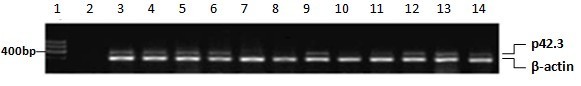
p42.3 expression in GC cell lines. 1: DNA marker 2: Negative control 3: AGS 4: MGC803 5: BGC823 6: SNU1 7: SNU5 8: SNU16 9: MKN45 10: RF1 11: RF48 12: N87 13: PAMC82 14: SGC7901.